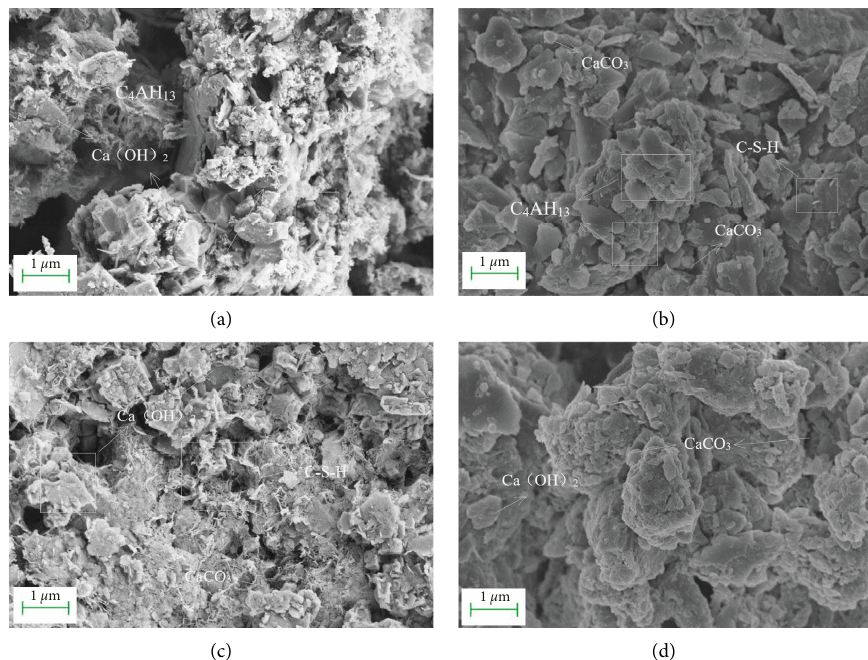
Figure 13: (a) L-MK before dry-wet cycle. (b) L-MK after dry-wet cycle. (c) NHL before dry-wet cycle. (d) NHL after dry-wet